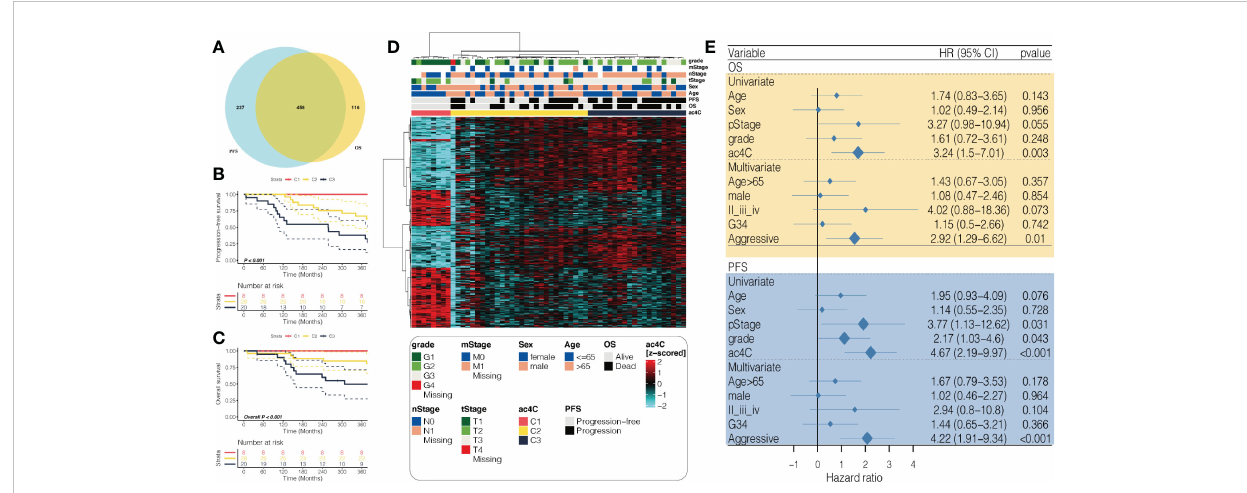
FIGURE 1 Identi fi cation of prognostic subtypes in PDAC based on NAT10-relevant gene set. (A) Venn diagram showing the intersection of prognostic NAT10- relevant genes regarding PFS in the left and OS in the right. (B) heatmap showing the unsupervised clustering using the prognostic NAT10-relevant genes in 56 PDAC cases in TCGA cohort. Kaplan-Meier curves for the three identi fi ed NAT10-relevant PDAC subtypes regarding both (C) PFS and (D) OS. (E) Forest plot showing the independent prognostic value of the NAT10-relevant subtypes after adjusting other clinical